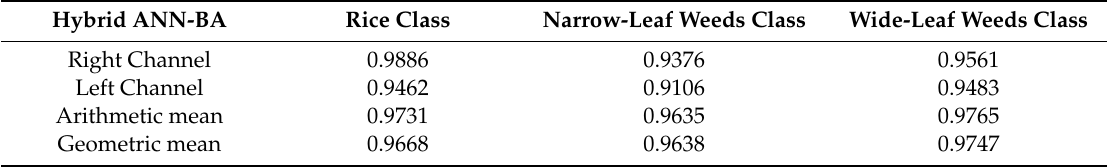
( i ) Figure 5. Segmentation and classification of rice and weeds in color and binary images for a frame. ( a ) Original frame, ( b ) color model of left channel, ( c ) binary model of left channel, ( d ) color model of right channel, ( e ) binary model of right channel, ( f ) color model of arithmetic mean, ( g ) binary model of arithmetic mean, ( h ) color model of geometric mean, and ( i ) binary model of geometric mean. 4. Conclusions